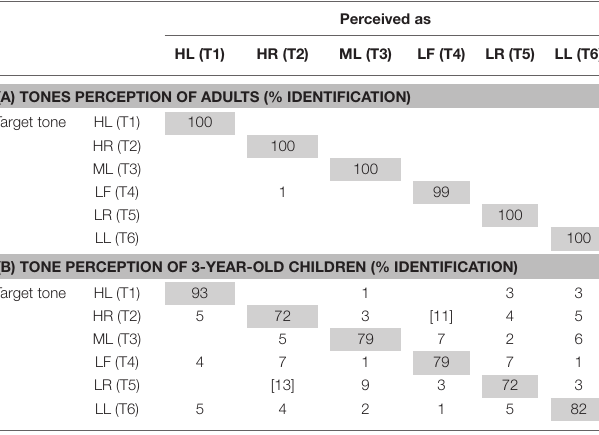
TABLE 3 | Confusion matrices of the tones perceived by adults and children measured by short form A of the Hong Kong Cantonese tone identification test. Perceived